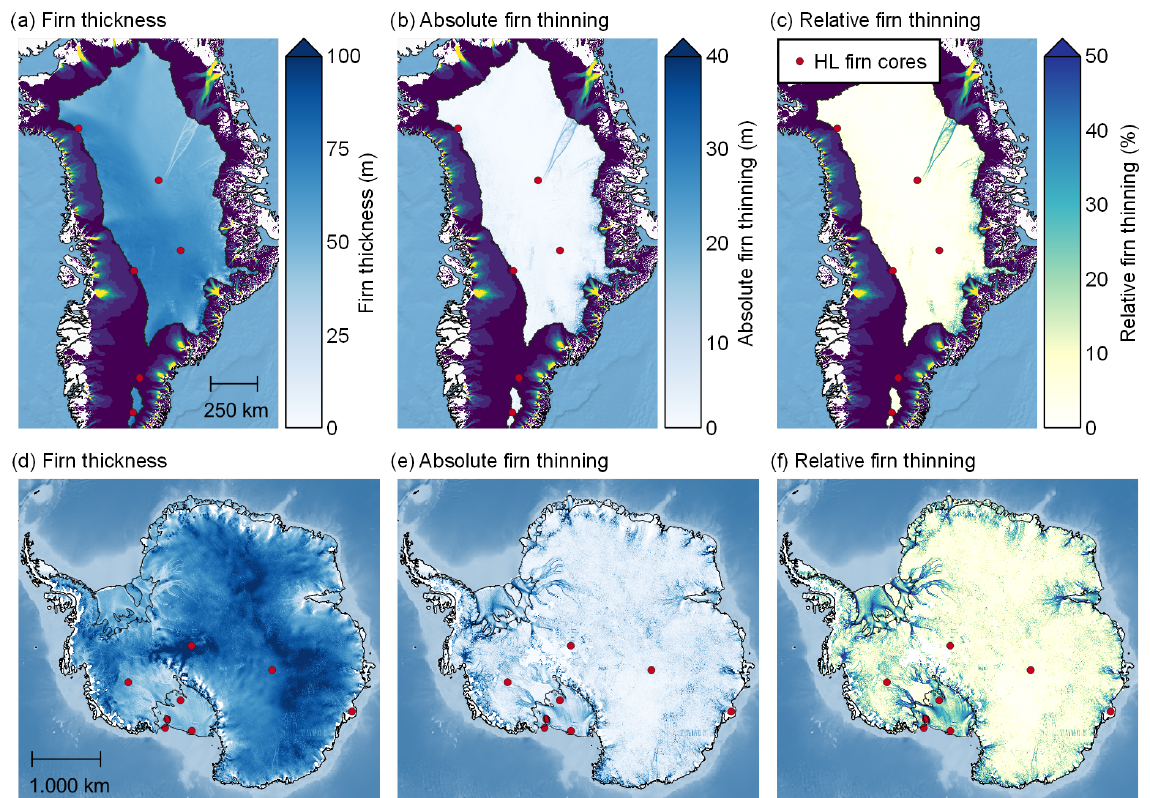
Figure 5. Study on the contribution of strain softening to firn densification in terms of the firn thickness over the dry zone of the Greenland ice sheet (GrIS, a – c ) and the Antarctic ice sheet (AIS, d – f ). (a, d) Modeled total firn thickness when strain softening is considered without the tuning bias correction. (b, e) Absolute firn thinning contribution caused by strain softening. (c, f) Relative firn thinning due to strain softening, which also illustrates by how much the densification process is accelerated by strain softening. Red dots indicate the drill locations of the firn cores that were used for tuning the empirical Herron–Langway model and illustrate that some of these firn cores were considerably affected by strain softening. Outside the dry zone of GrIS the surface velocity is shown with brighter colors indicating faster